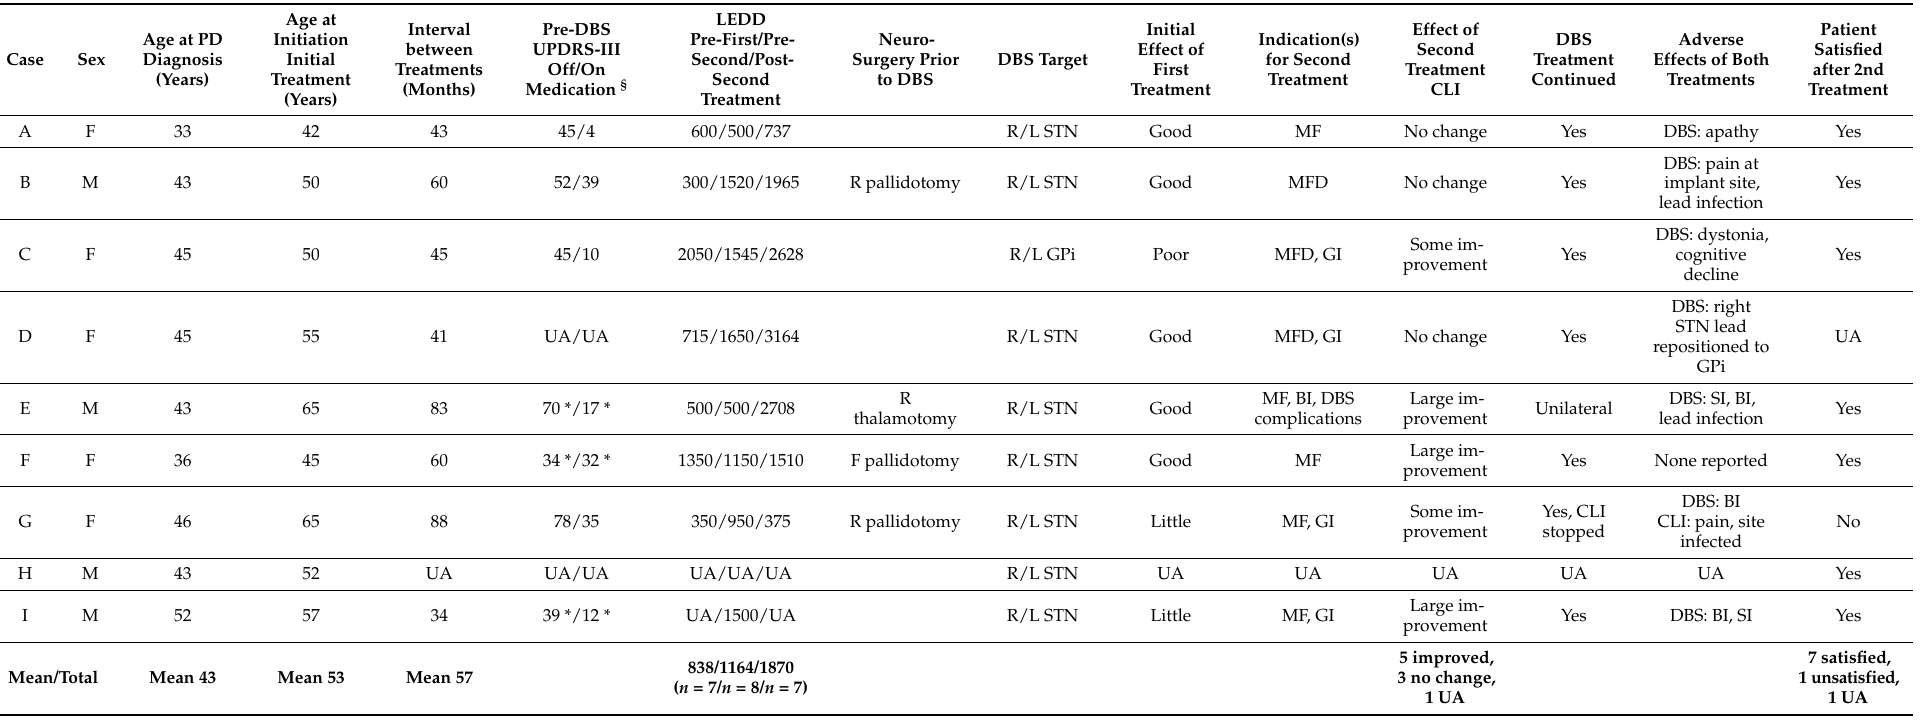
Table A1. Parkinson’s disease patients firstly treated with DBS, CLI as second treatment—single